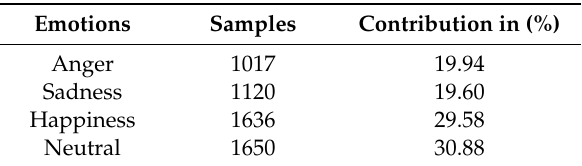
Table 2. The detailed description about the interactive emotional dyadic motion capture IEMOCAP dataset about the emotions, the numbers of utterances, and the participation rates in percentage.